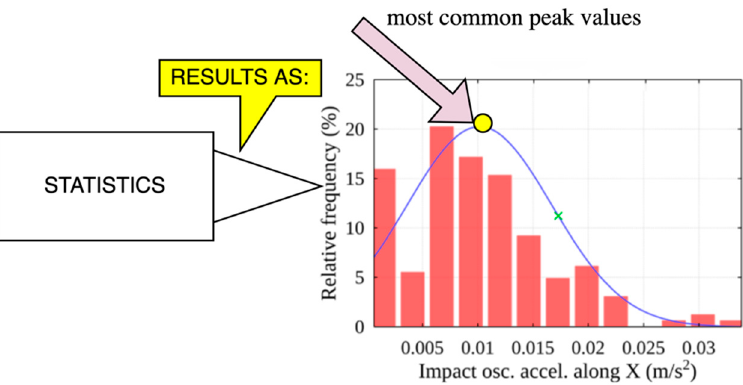
Figure 4. Statistical analysis process deconstruction with threshold levels establishment.